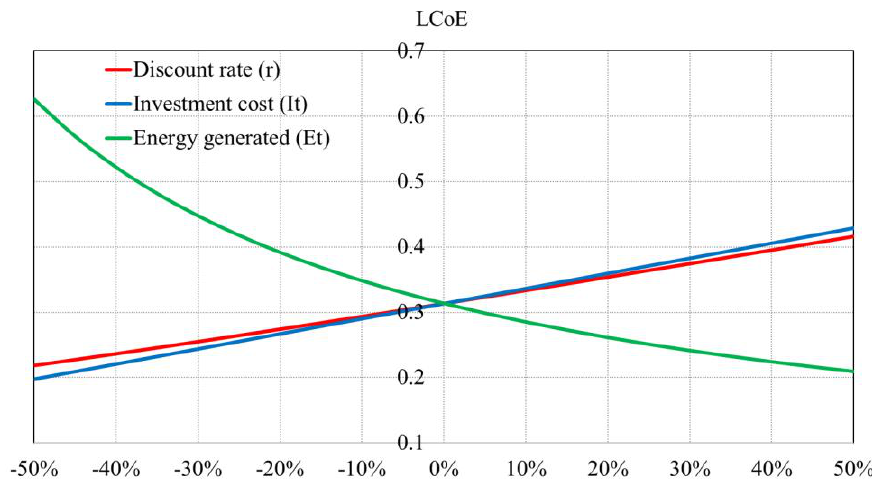
Figure 33. Sensitivity analysis on the LCoE of the PV array.